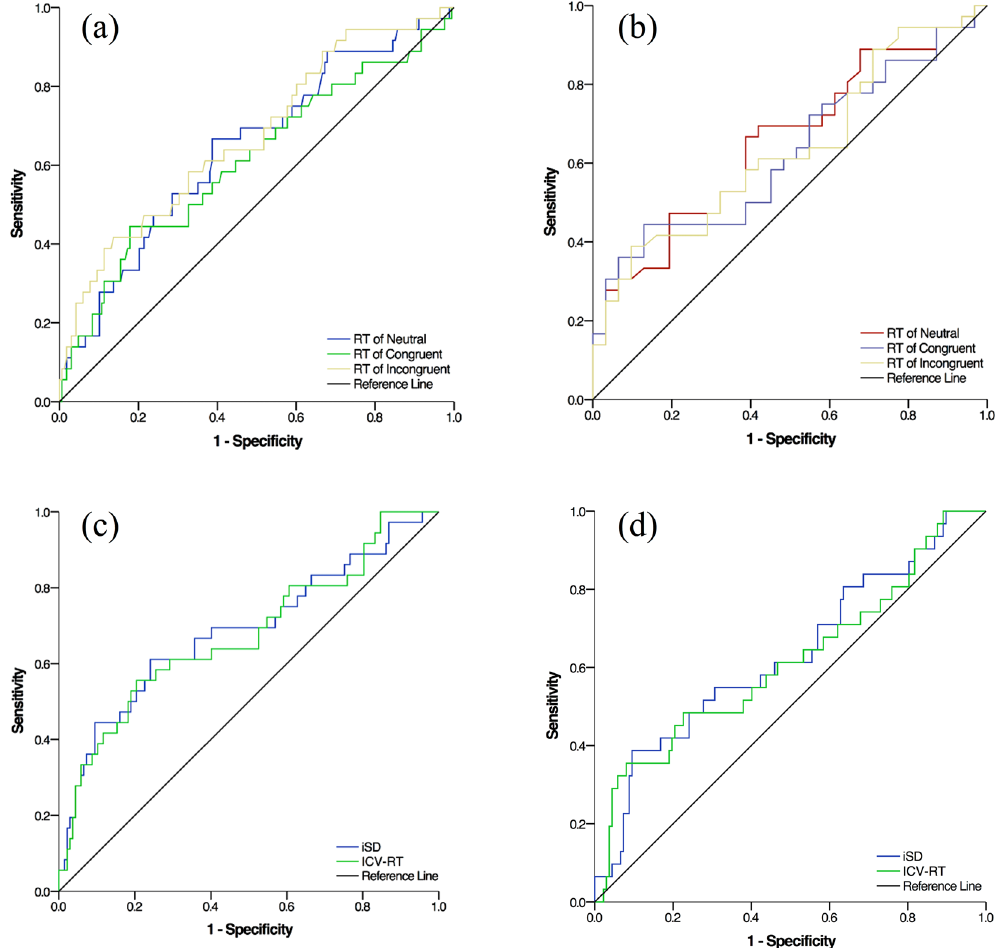
Figure 2. Receiver operator characteristic curves for the ‘two-level’ measurements of processing speed in the adults with different cognitive status. Mean RT of three flanker types presents a modest power to differentiate NCD-AD ( a ) from healthy and NCD-vascular groups ( b ). The indices of intra-individual variability of RT shows a utility to discriminate NCD-AD ( c ) and NCD-vascular ( d ) from healthy